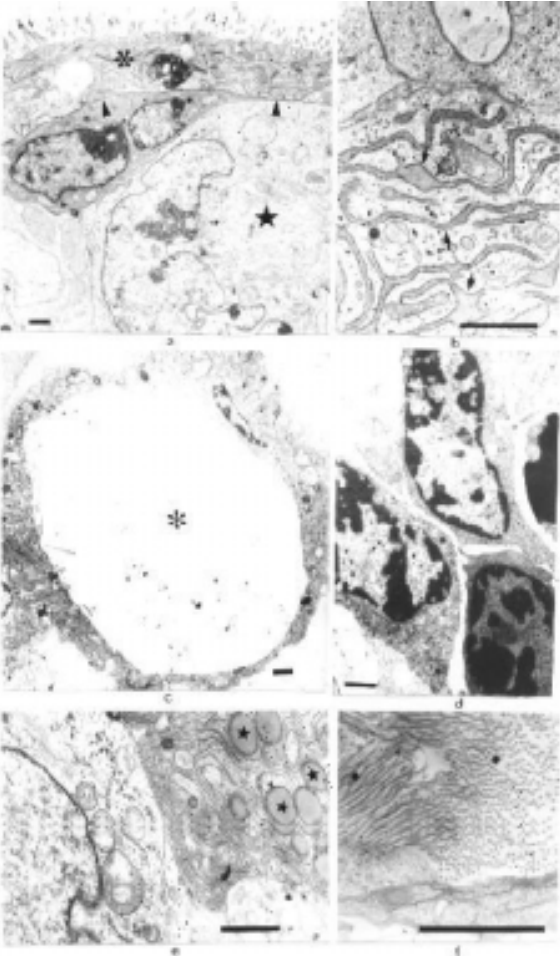
Figure 6 - Electron micrographs showing parts of HESS-1, HESS-2 and HESS-3 derived embryoid bodies (EBs). An advanced degree of differen- tiationcanbeseeninthree-dayEBsasfollows:HESS-2-derivedembryoid body (EB) showing Riechert‘s membrane ( (cid:1) ) which separates an endo- dermal layer (*) formed by cells with multiple microvilli ( ↑ ) and the cyto- plasm enriched with organelles, the asterisk marks cells resembling embryonic fibroblasts (6a, 5000x); HESS-1-derived EB showing a frag - ment of the granular endoplasmatic reticulum ( ↑ ) typical of fibroblasts (6b, 19000x). Nine-day EBs: HESS-1-derived EB showing a well formed cystic cavity (*) (6c 5200x); center of a HESS-2-derived EB showing areas resembling blood cell islands (6d, 8700x); HESS-3-derived EB showing fibroblast-like cells with granular endoplasmatic reticulum and polysaccharide granules ( (cid:2) ) (6e, 15000x); HESS-2-derived EB with a large amount of collagen produced by condroblasts (–) (6f, 32000x). Bar = 1 µ